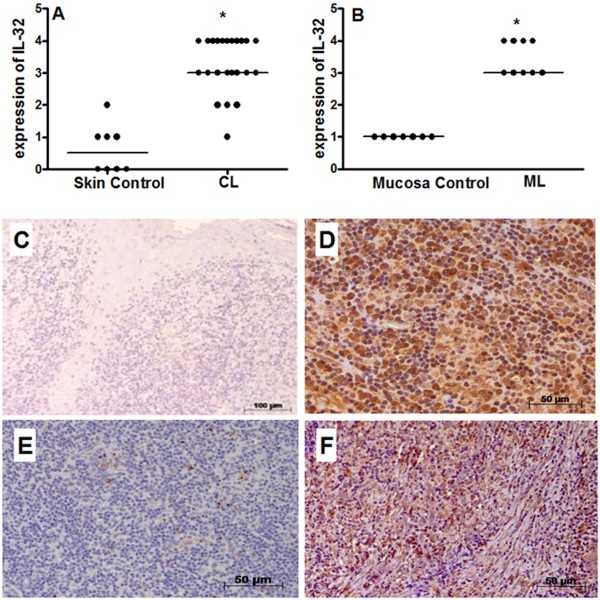
IL-32 is detected in cutaneous and mucosal lesions of ATL patients. Fragments of cutaneous lesions (CL, n = 23, A) or mucosal lesions (ML, n = 9, B) and healthy tissues (skin, n = 8; mucosa, n = 7) were included in paraffin and sections were submitted to IHC for IL-32. After reaction, the expression of IL-32 was determined through positive cells, analysed under light microscopy. The data represent individuals and medians values. *p < 0.05. Panel C: photomicrography of skin control. Panel D: photomicrography of CL lesion positive for IL-32. Panel E: photomicrography of mucosa control. Panel F: photomicrography of ML lesion positive for IL-32.